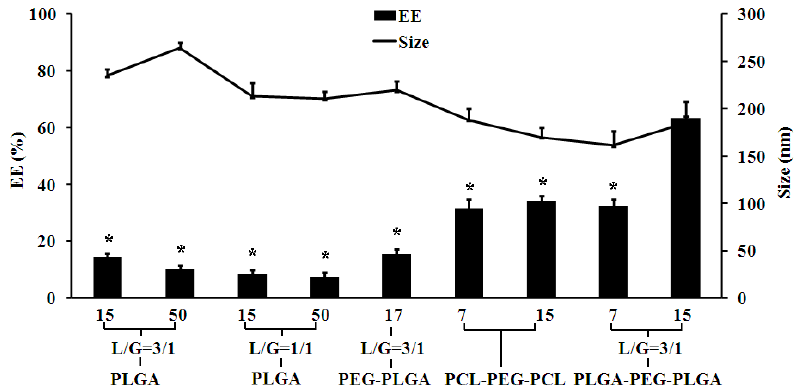
Figure 2. The effect of polymer types on the entrapment efficiency (EE) and size of Sal-LPNPs (mean ± SD, n = 3). * indicated there was significant difference ( p < 0.05) compared to PLGA-PEG-PLGA (15 KD) group. The polymer type and M the X axis. L/G was the lactide/glycoside molar ratio in PLGA or polymers containing PLGA block.